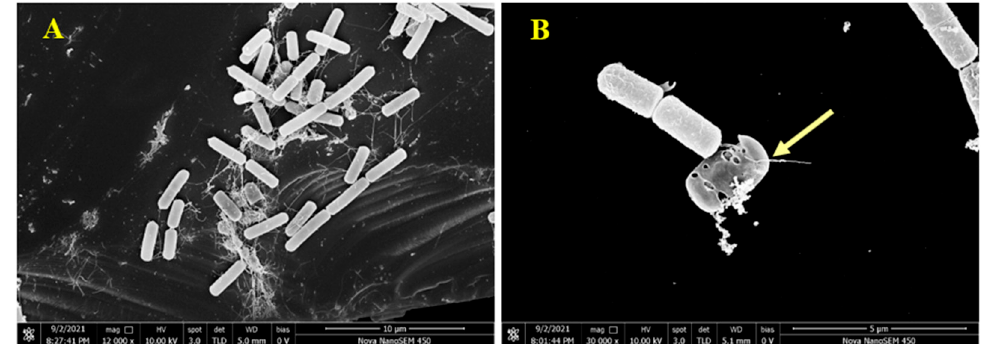
Figure 6. Scanning electron microscopy (SEM) images of B. cereus ; ( A , B ) SEM images of control and treatment for B. cereus by 1 , respectively.